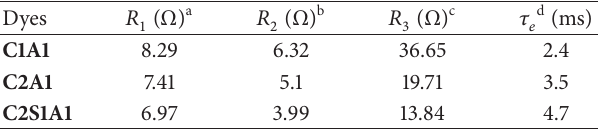
Table 3: Performances of mercurochrome and organic dye based dye-sensitized solar cells and electron transport properties of their photoanodes as determined by impedance analysis. Cell areas are 0.24 cm 2